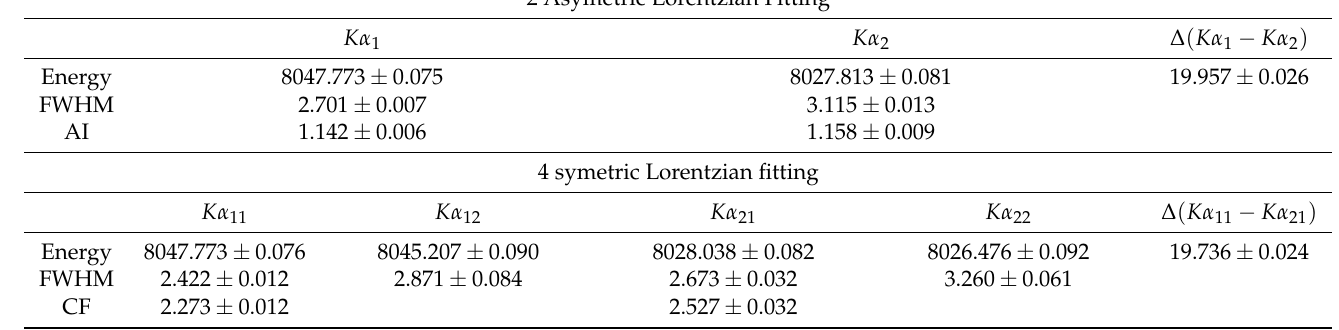
Table 2. Line energies and FWHM, in eV, and Asymmetric indexes (AI), resulting from fitting Cu K α 1,2 emission lines with two asymmetric, and four symmetric Lorentz functions, for the evaluation of the repeat stability of the double-crystal X-ray spectrometer. CF is the corrected FWHM, in eV, by Tochio’s method